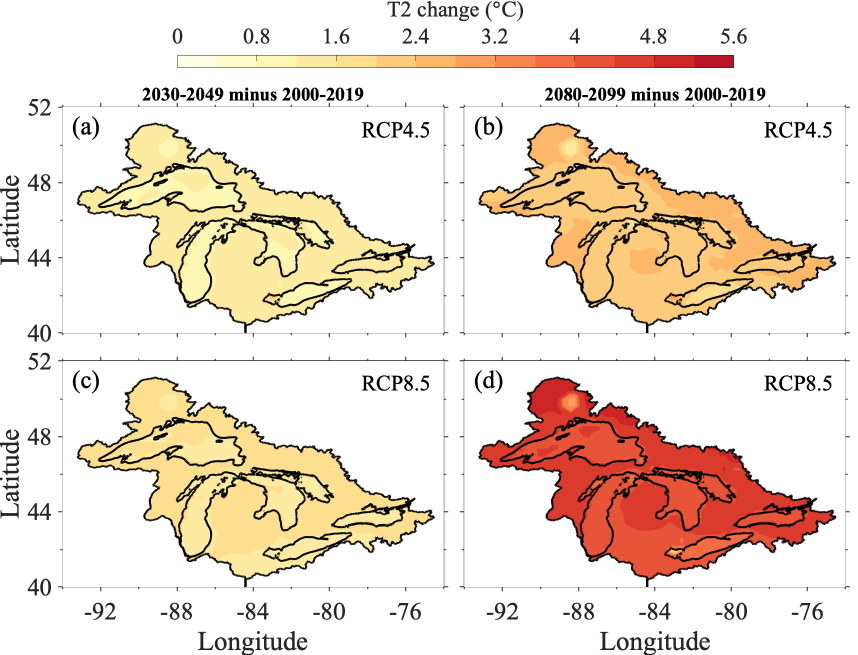
Figure 6. Projected changes in the annual mean surface air temperature over the Great Lakes basin during the mid-century (2030–2049) and late century (2080–2099) for the RCP 4.5 (a, b) and RCP 8.5 (c, d) scenarios relative to the present-day climate (2000–2019).